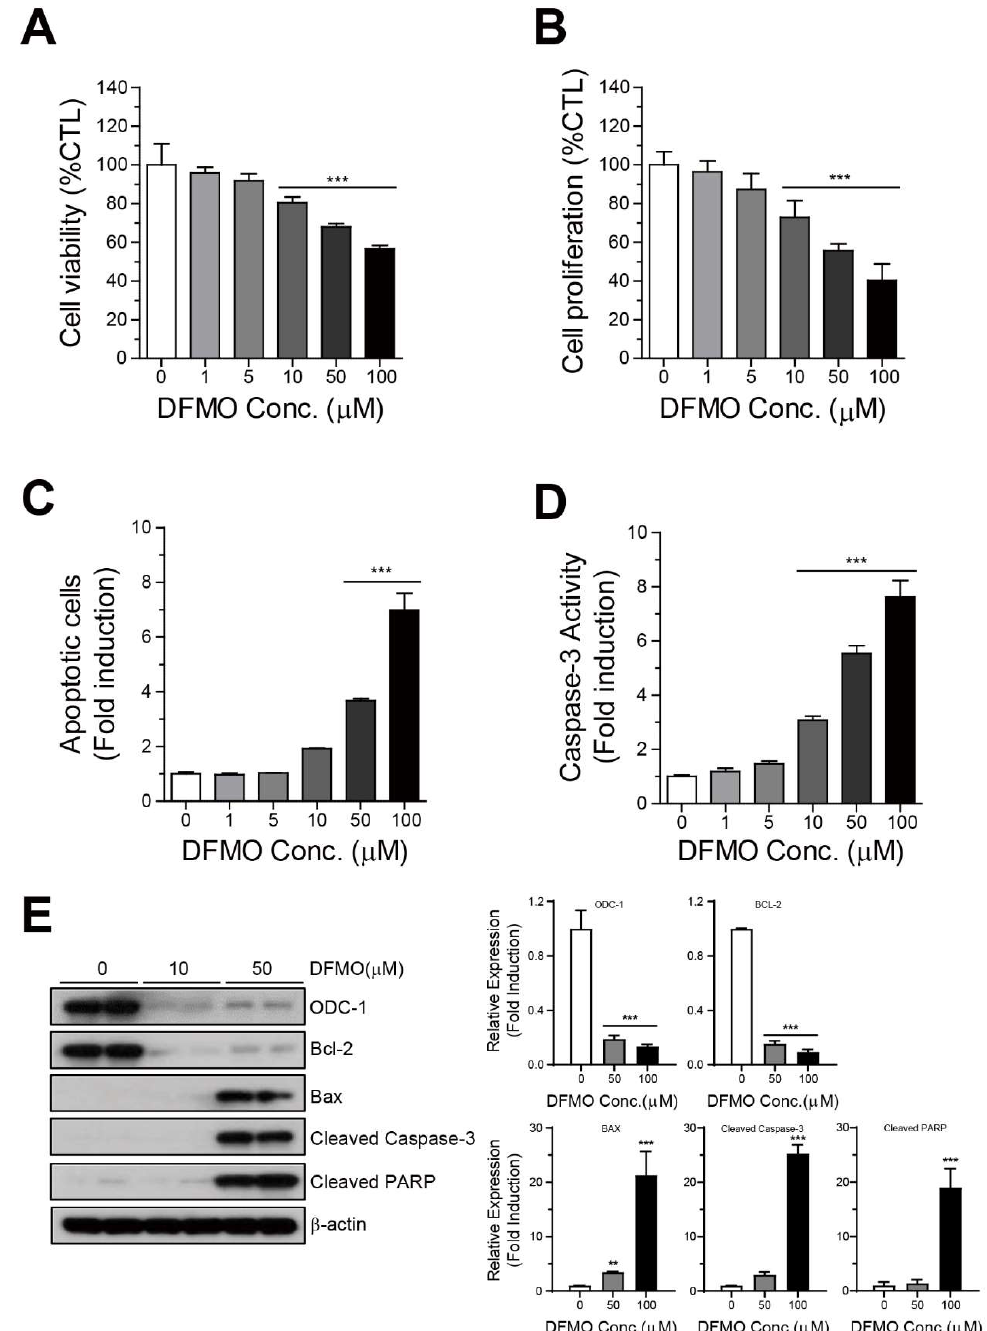
Figure 1. Inhibition of cell survival and induction of apoptotic cell death by DFMO in SKOV-3 cells. ( A ) SKOV-3 cells were cultured with varying concentrations of DFMO (from 0 to 100 µM) for 48 h, and cell viability was detected using the PrestoBlue assay. ( B ) Cell proliferation was determined by analyzing ATP content in DFMO-treated SKOV-3 cells using the CellTiter-Glo assay. ( C ) Flow cytometric analysis of Annexin V-FITC/PI-stained SKOV-3 cells treated with the control (0.1% DMSO) or 0–100 µM DFMO was used to determine the apoptotic rates of SKOV-3 cells under various concentrations of DFMO. ( D ) Caspase-3 activity in DFMO-treated SKOV-3 cells was measured using the Luciferase Assay (Caspase-Glo 3/7 Assay system). ( E ) Western blot and quantification analysis for the apoptotic proteins Bcl-2, Bcl-xL, Bax, cleaved caspase-3, and cleaved PARP in cells treated with DFMO. The controls were treated with 0.1% DMSO. Data are expressed as mean ± SD. ** p < 0.01, *** p < 0.001 compared with the